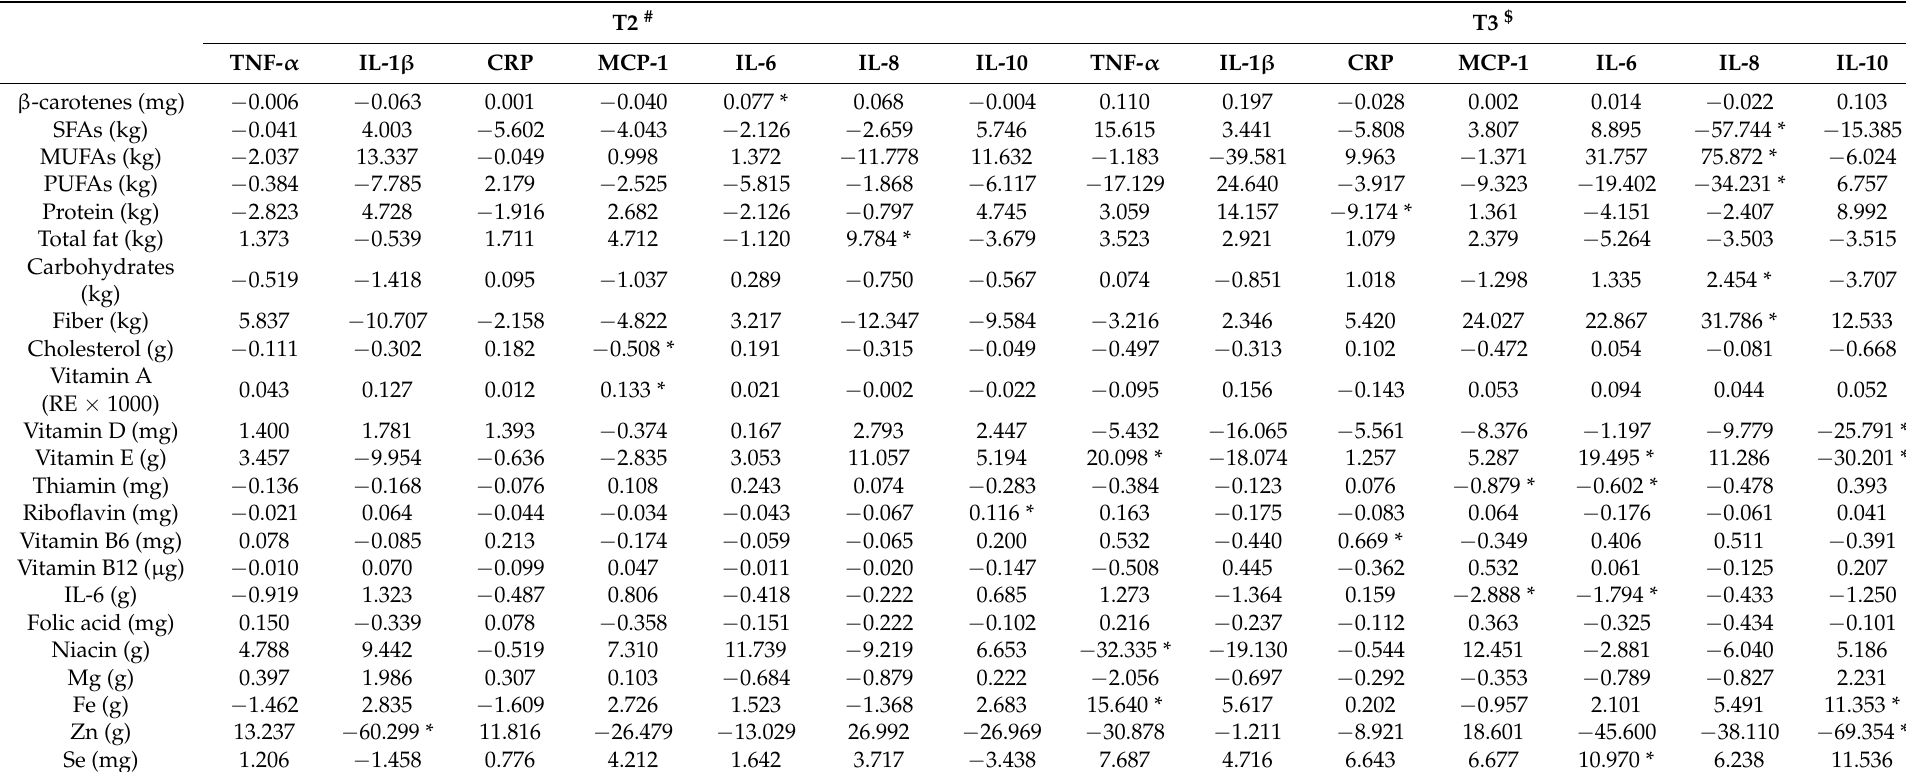
Table 3. Multivariate general linear model analysis of cytokine levels and major nutrients/food components